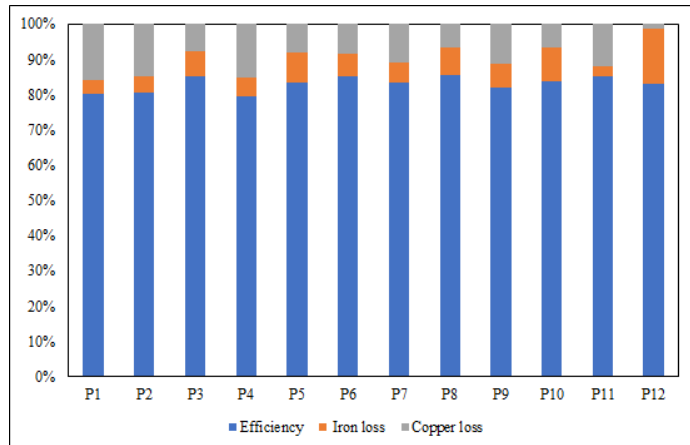
Figure 22. Efficiency at different velocities.